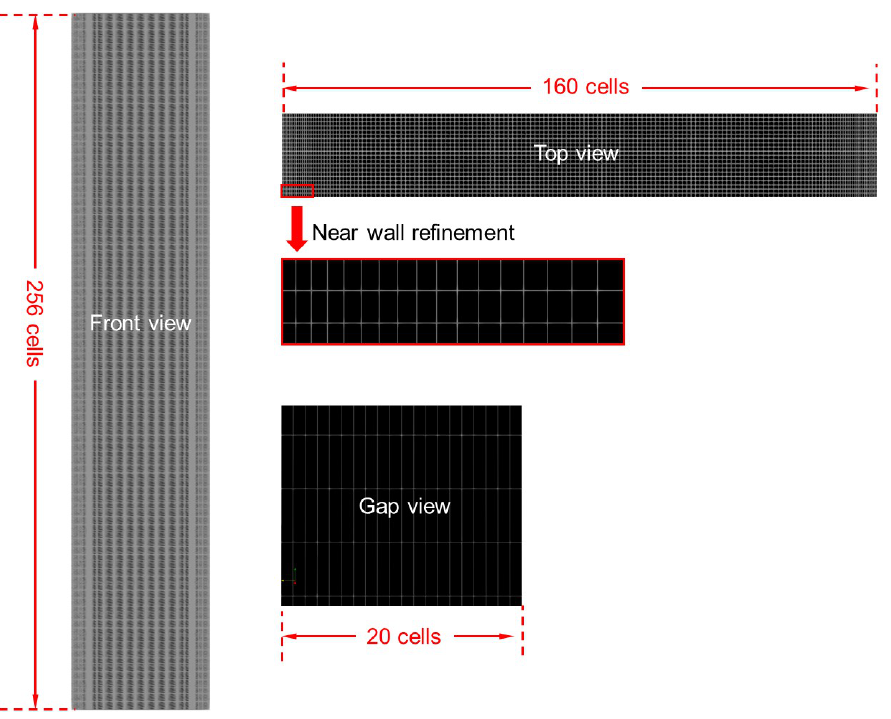
Figure 3. The mesh grids used for CFD